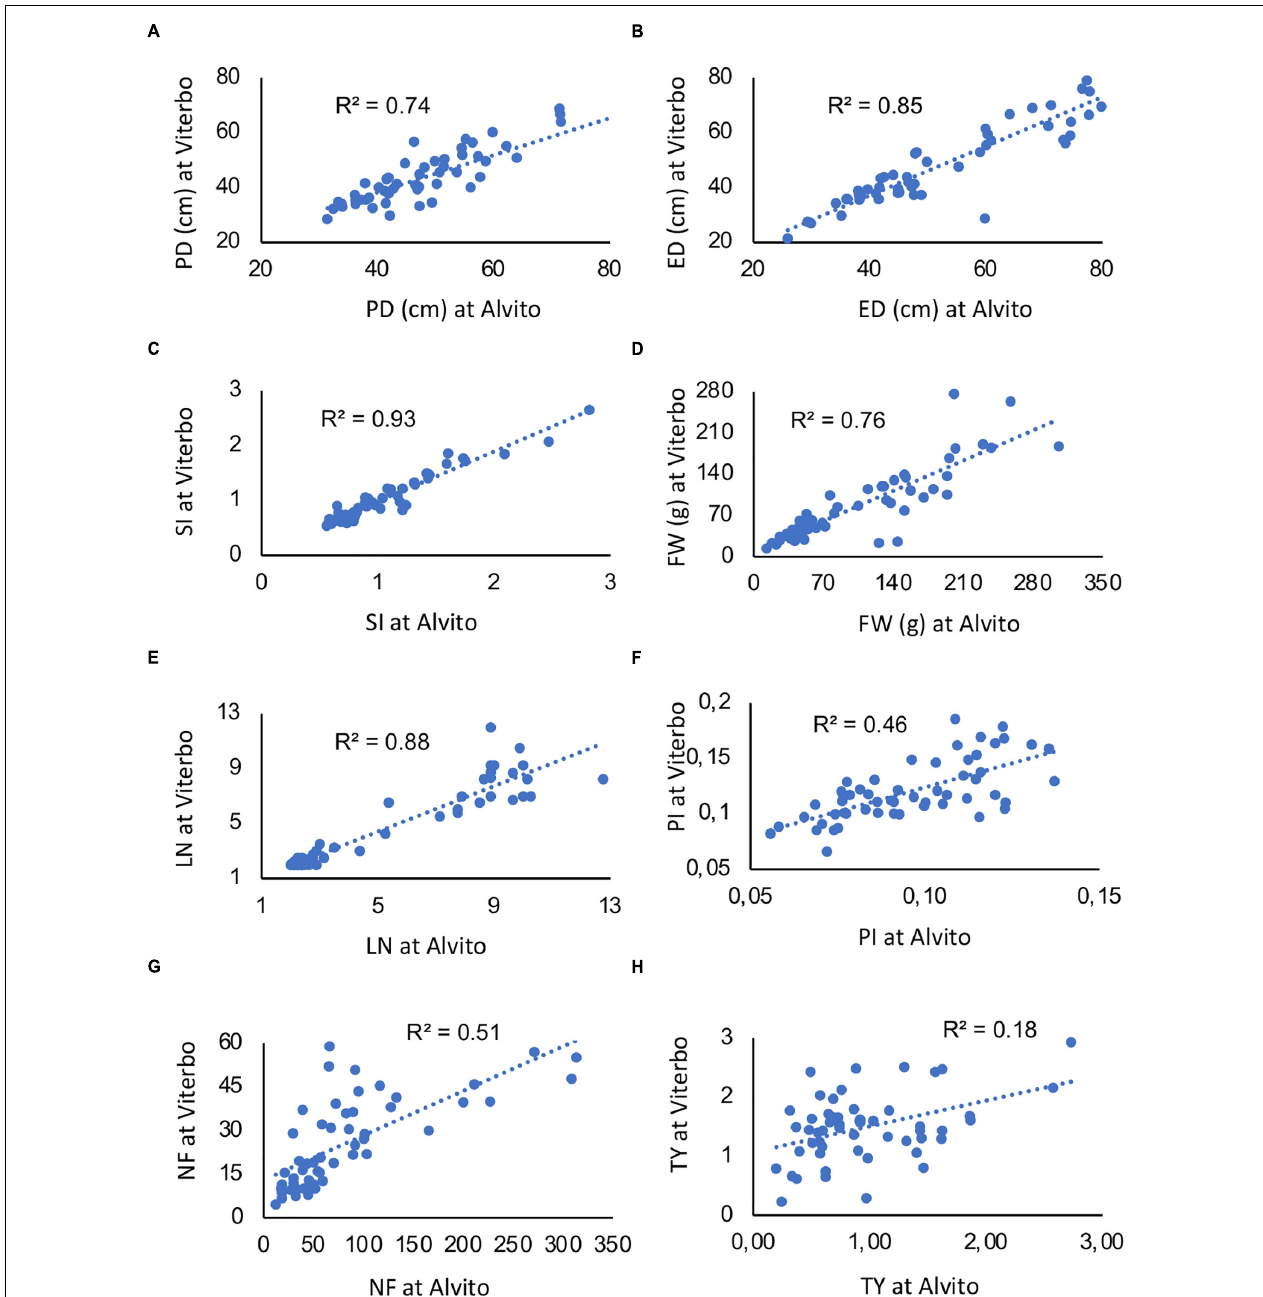
FIGURE 5 | Linear regressions among quantitative traits measured on the 64 studied accessions in two cultivation environments, Viterbo and Alvito. (A) Polar diameter (PD), (B) equatorial diameter (ED), (C) fruit shape index (SI), (D) fruit weight (FW), (E) locule number (LN), (F) pericarp index (PI), (G) fruit number (NF), and (H) total yield (TY). The determination coefficient ( R 2 ) is reported within each panel; all regressions are significant for p ≤